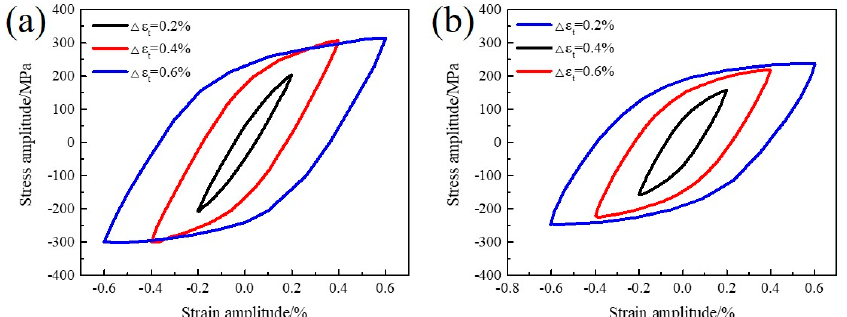
Figure 7. The superimposed hysteresis loops of the specimens at different strain levels: ( a ) novel steel and ( b ) 30SiMn2MoV.